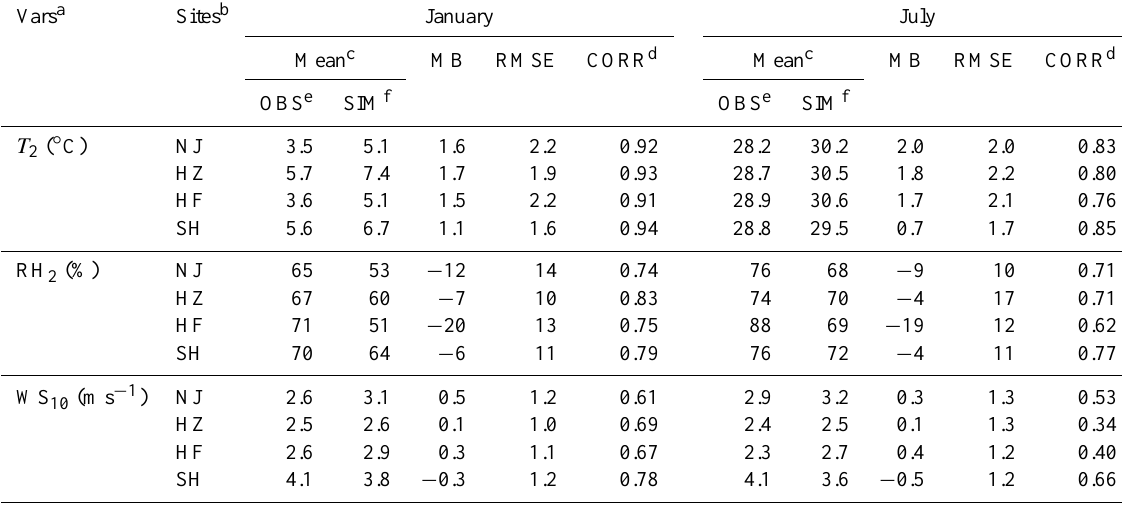
Table 3. The statistics of meteorological conditions from the ADDAH simulation at four sites. Vars a Sites b